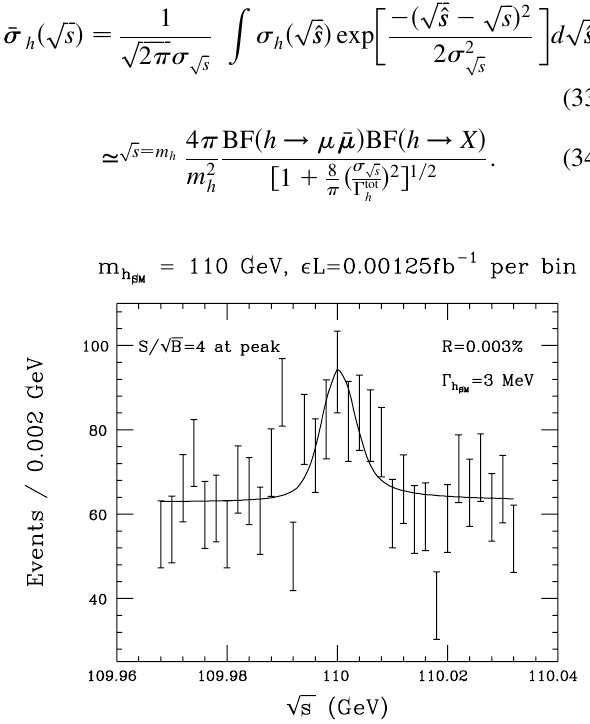
FIG. 10. Number of events and statistical errors in the bb final state as a function of (cid:8)(cid:8)(cid:8) s assuming R (cid:4) 0 : 003% , and >L (cid:4) 0 : 001 25 fb (cid:1) 1 at each data